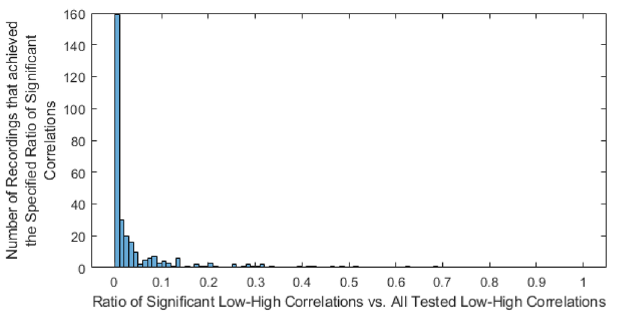
Figure 6. Histogram of the number of analysed recordings that achieved different ratios of significant-to- all-tested low-high correlations. The vast majority of recordings had almost no significant below-10 to above- 100 Hz correlations. The FDR was controlled at an α of 0.01. A total of 300 recordings were analysed.